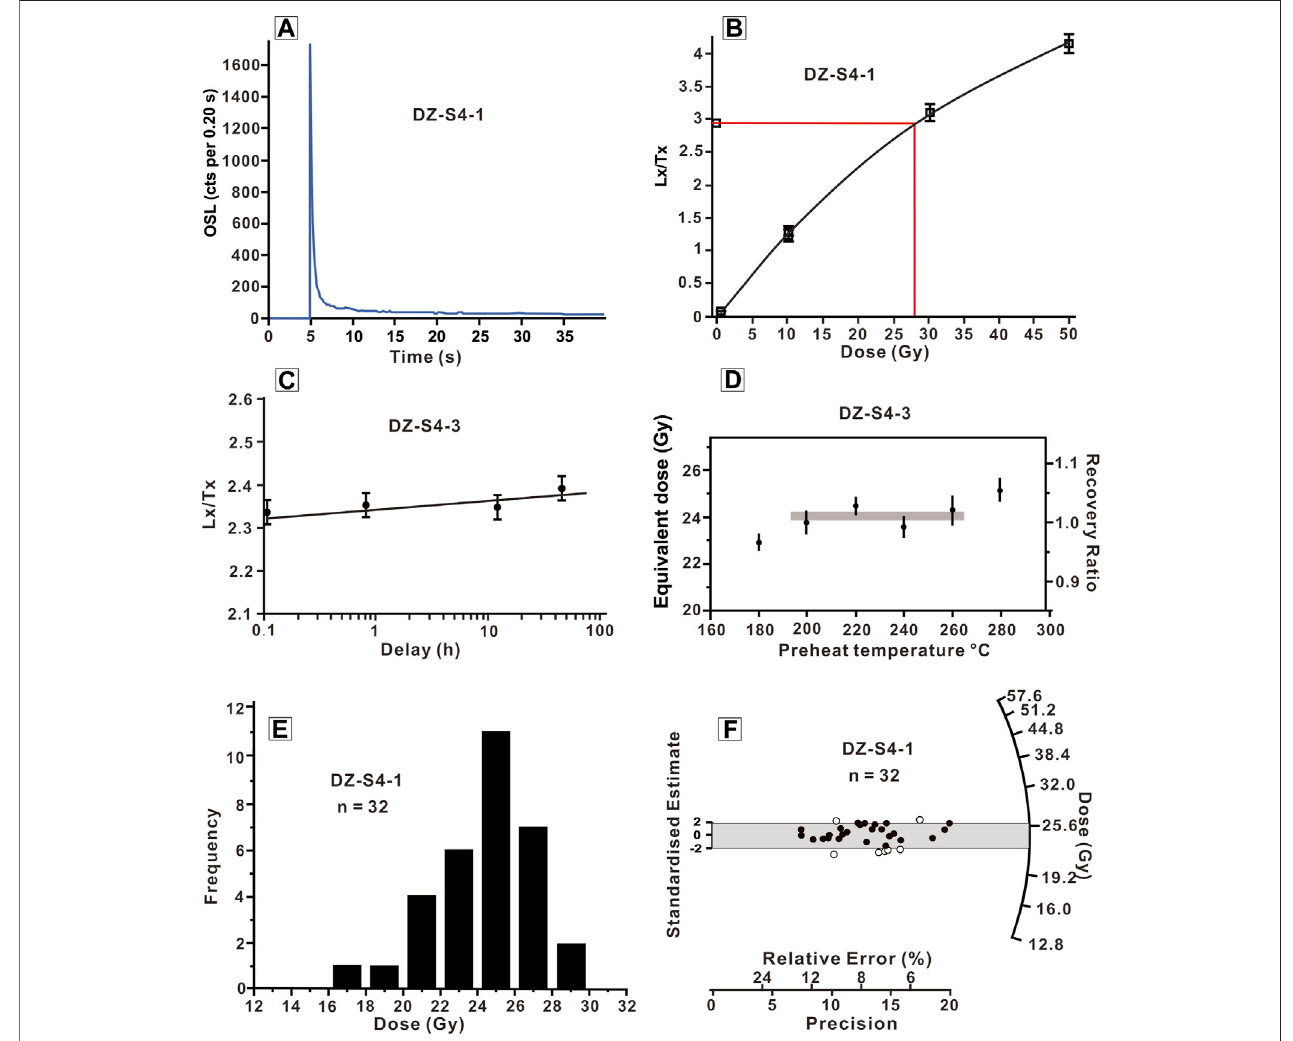
FIGURE3 | OSL decay curve and dose – responsecurvefor the sample ofDZ-S4-1 (A,B) ,fading test ofquartz from sample DZ-S4-3 (C) , preheat plateau tests for DZ-S4-3, (D) and D e distributions in histograms and radial plots for sample DZ-S4-1 (E,F) .